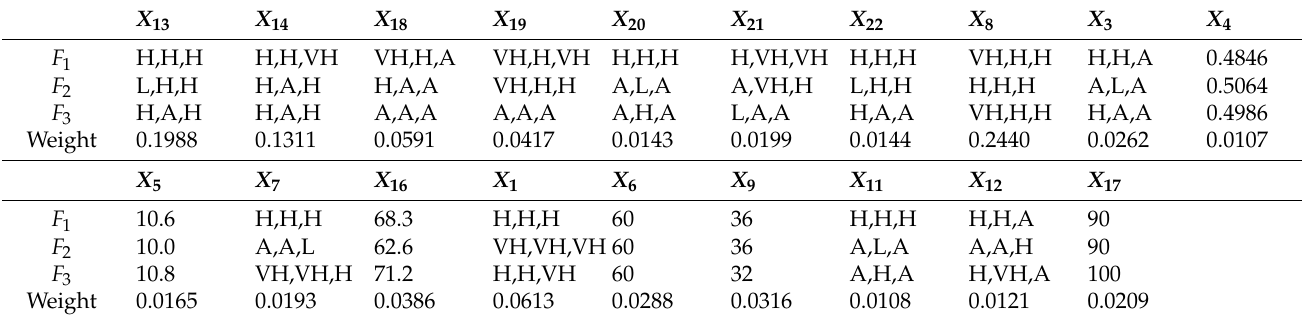
Table 12. Criteria performance evaluations of